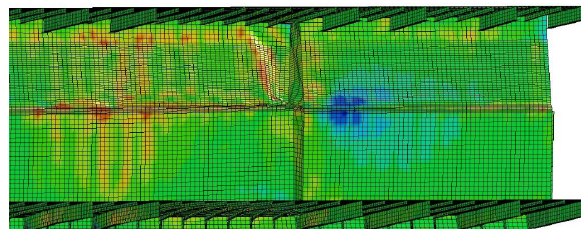
Figure 13: Pressure contour after collision at Location 2.